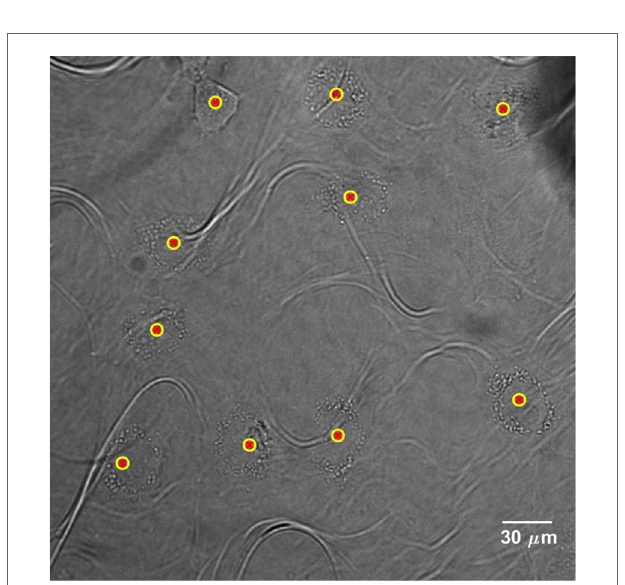
FIGURe 3 | Cell detection application on bright-field image of heLa human cervix cells, acquired with a 40 × objective . Yellow-red markers define the x – y positions that characterize the cell presence. The “loop” artifacts originate from the polypropylene substrate since it becomes transparent in bright-field